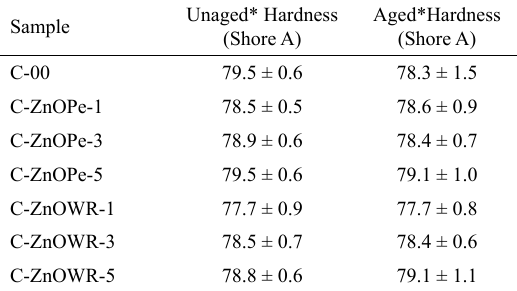
Table 3. Median values of hardness in aged and unaged ZnO loaded TPE compounds.